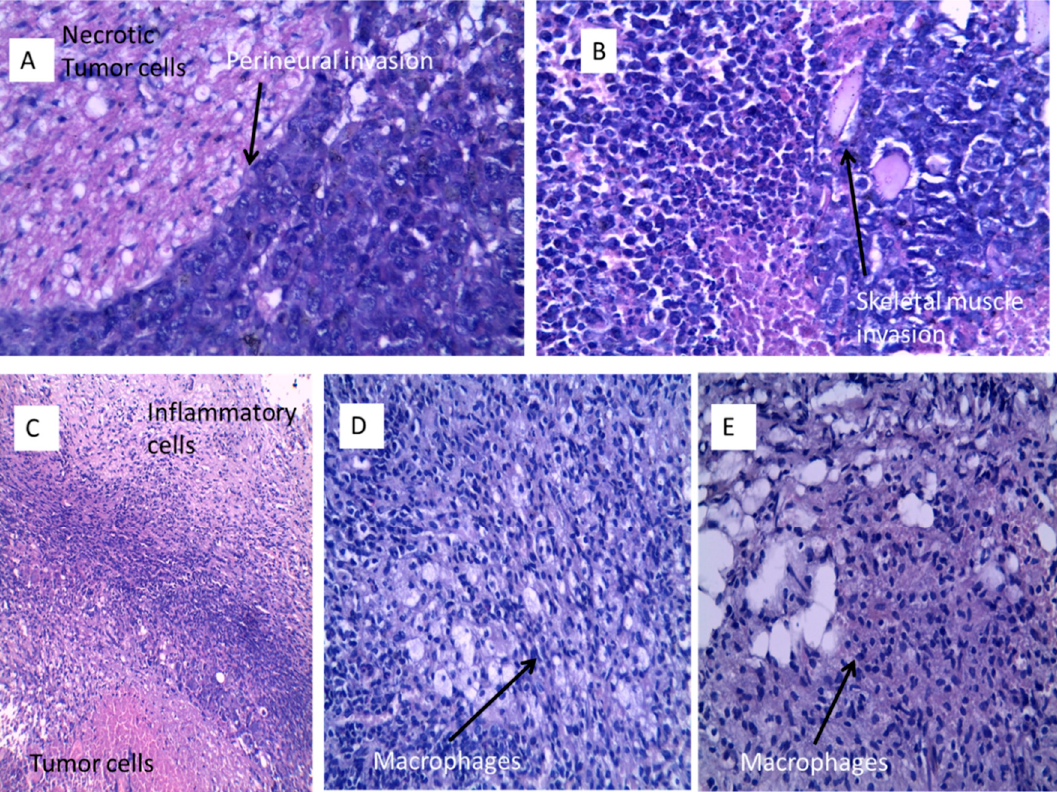
Figure 11. Histopathological findings of SEC sections stained with H&E. Group I ( A ) showing large necrotic centers surrounded by undifferentiated carcinomatous cells (H&E ×400). Group II ( B ) showing the cellular details of the tumor, the cells are spherical in shape, containing relatively large, highly chromatophilic nuclei with one or more prominent nucleoli, giant tumor cells are also seen (H&E ×400). Group III ( C ) showing viable and necrotic tumor cells surrounded by a layer of × 100), ( D ) showing partial responding samples with macrophages and mononuclear cellular infiltrate inflammatory cells (H&E ×100), ( D ) showing partial responding samples with macrophages and (H&E × 400) and ( E ) showing complete absence of viable or necrotic tumor cells with macrophages and mononuclear cellular infiltrate (H&E ×400) and ( E ) showing complete absence of viable or necrotic lymphocytes infiltration (H&E × tumor cells with macrophages and lymphocytes infiltration (H&E ×400).